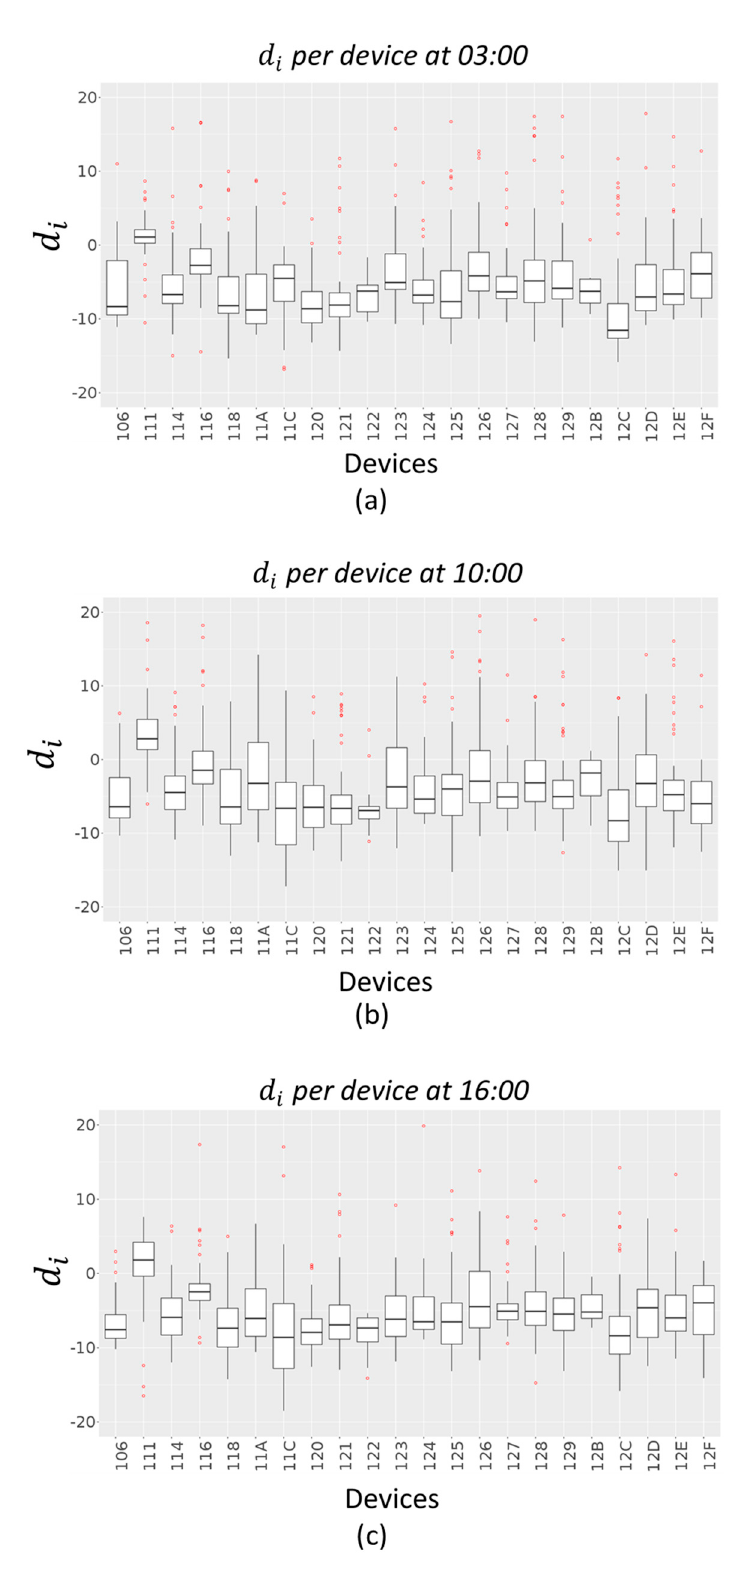
Figure 11. PM 10 working days error box plots per device (IDW Method) at 03:00 ( a ), 10:00 ( b ) and 16:00 ( c ).